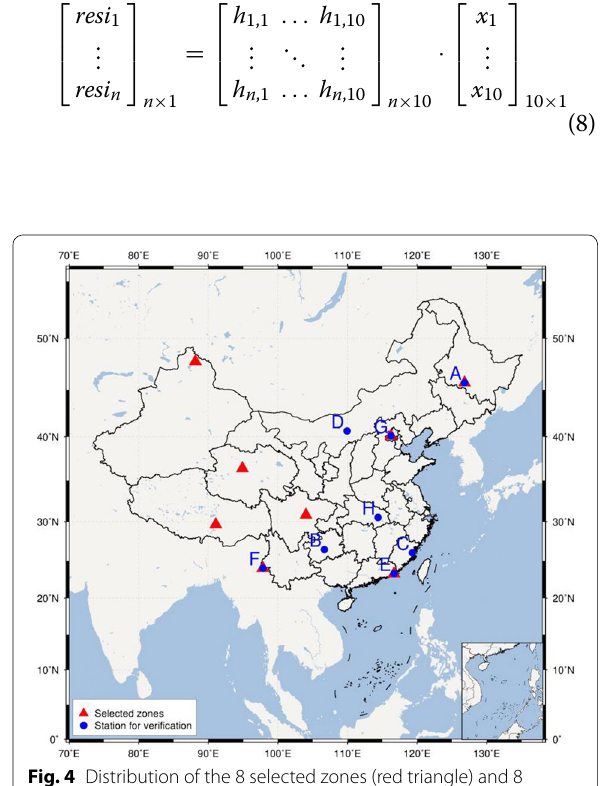
Fig. 4 Distribution of the 8 selected zones (red triangle) and 8 positioning stations (blue point) used for verification